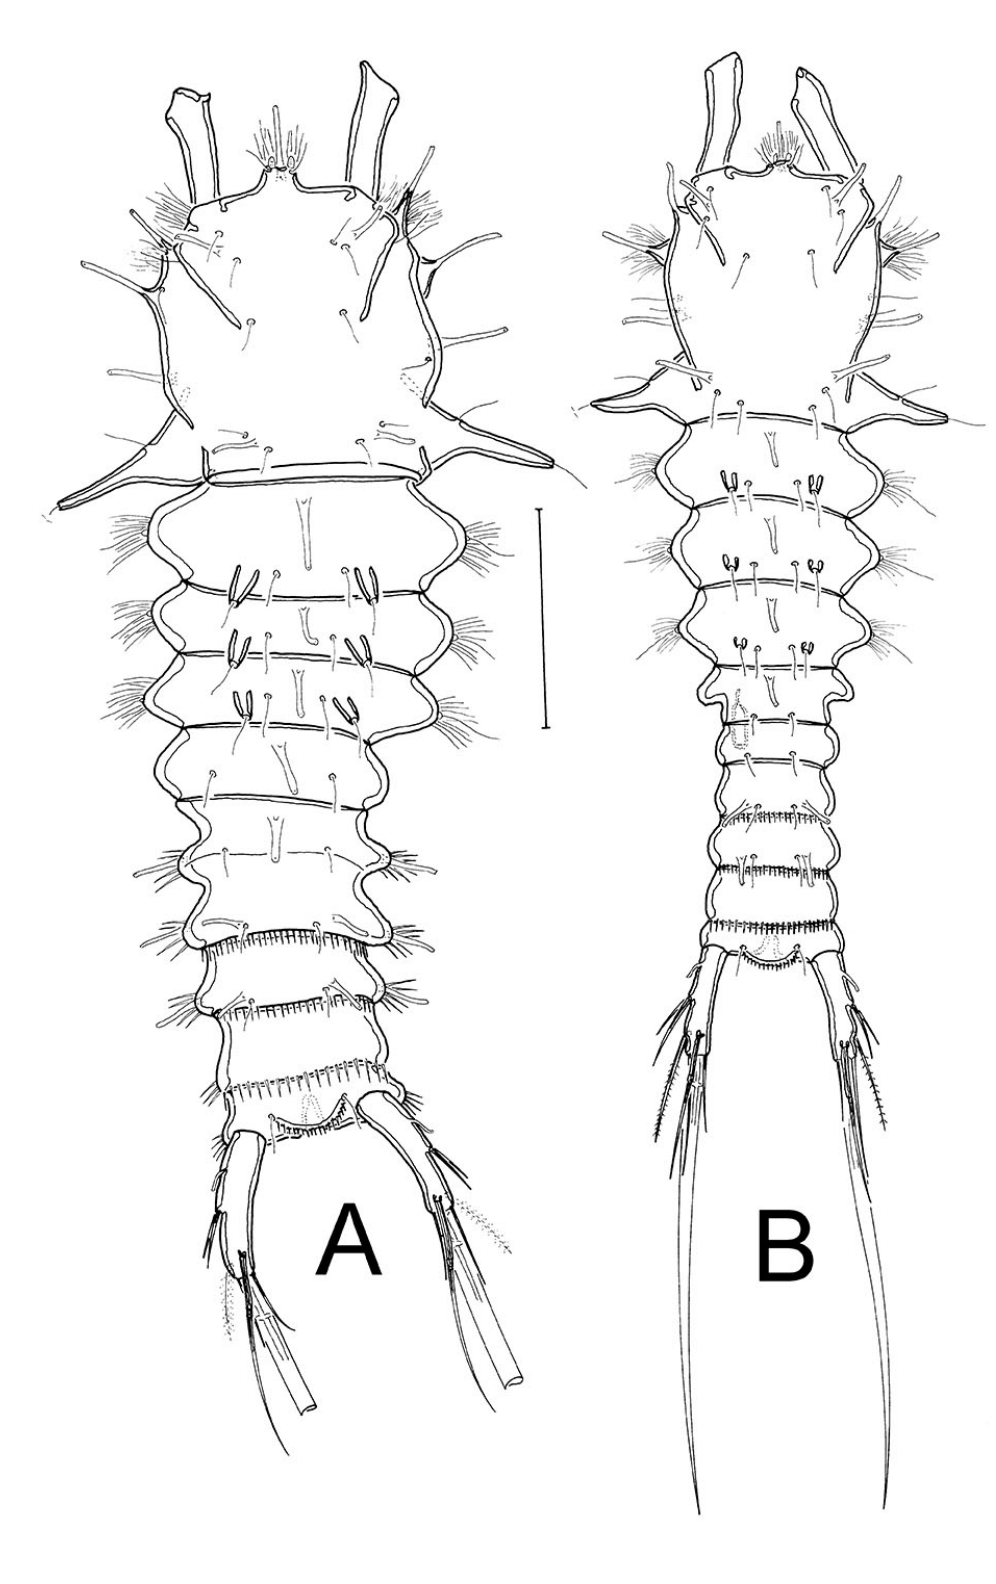
Fig. 8. Paratouphapleura aaroni gen. et sp. nov. A . Female holotype (SMF 37270/1), habitus, dorsal view. B . Male allotype (SMF 37271/1), habitus, dorsal view. Scale bar: 100